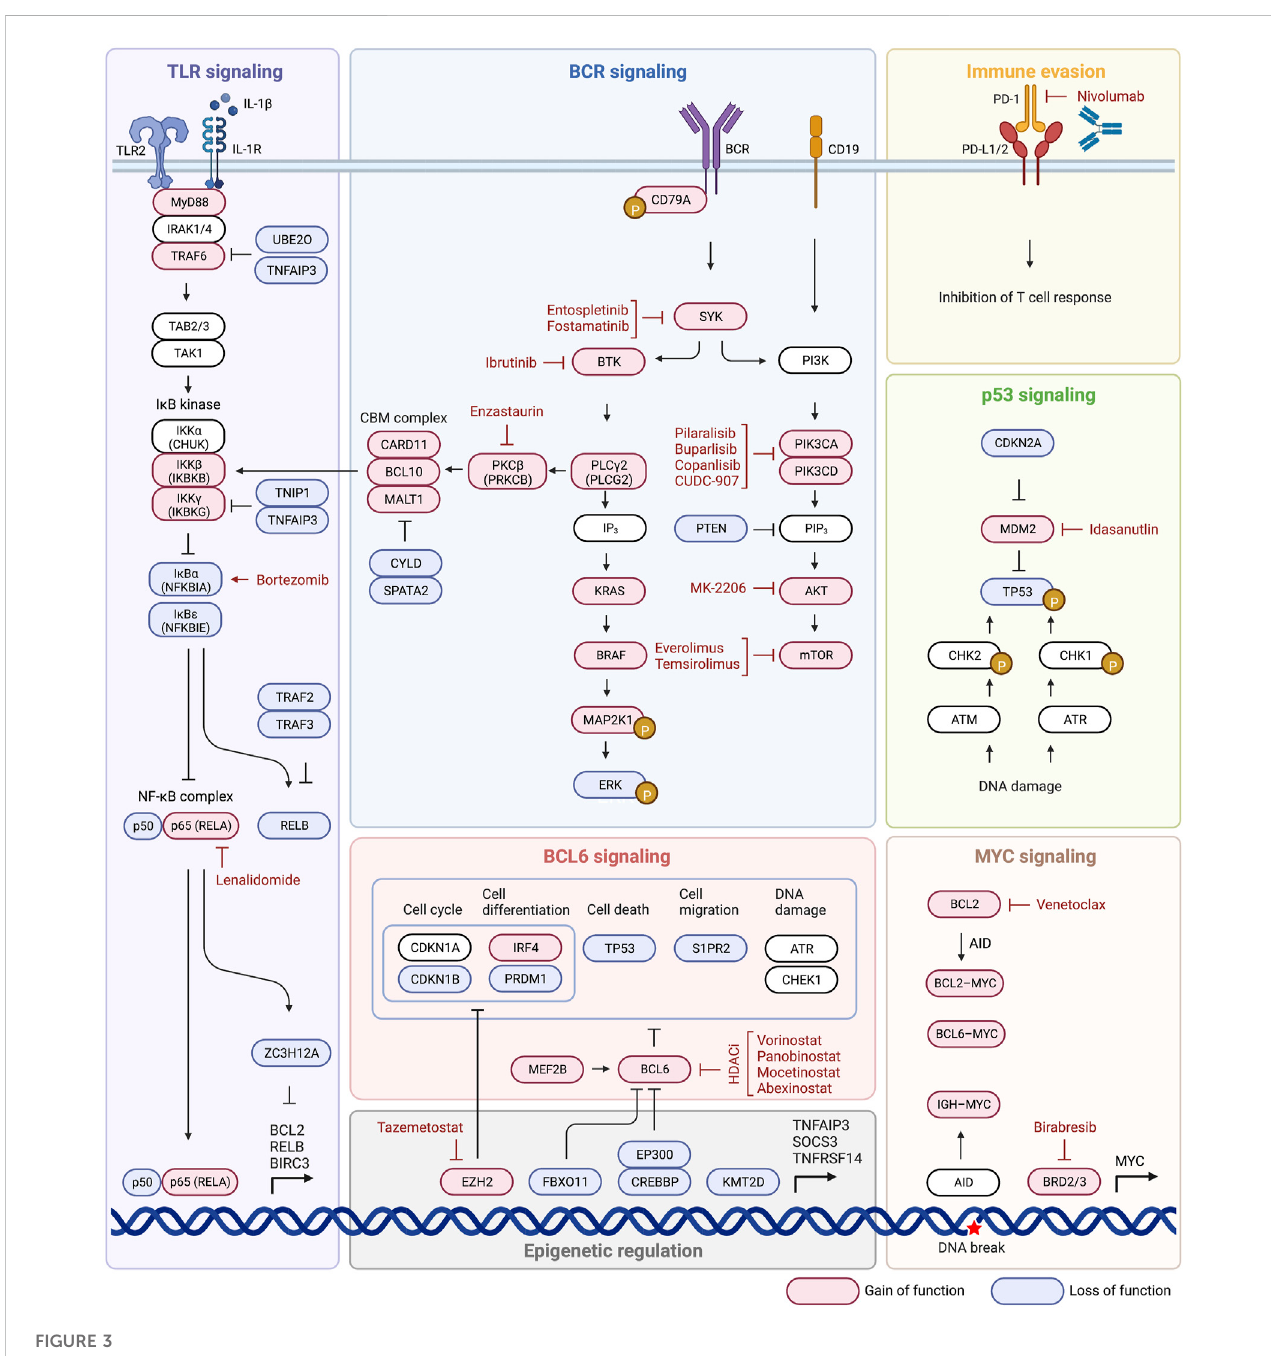
FIGURE 3 Targeted therapeutic strategies and potential inhibitors in